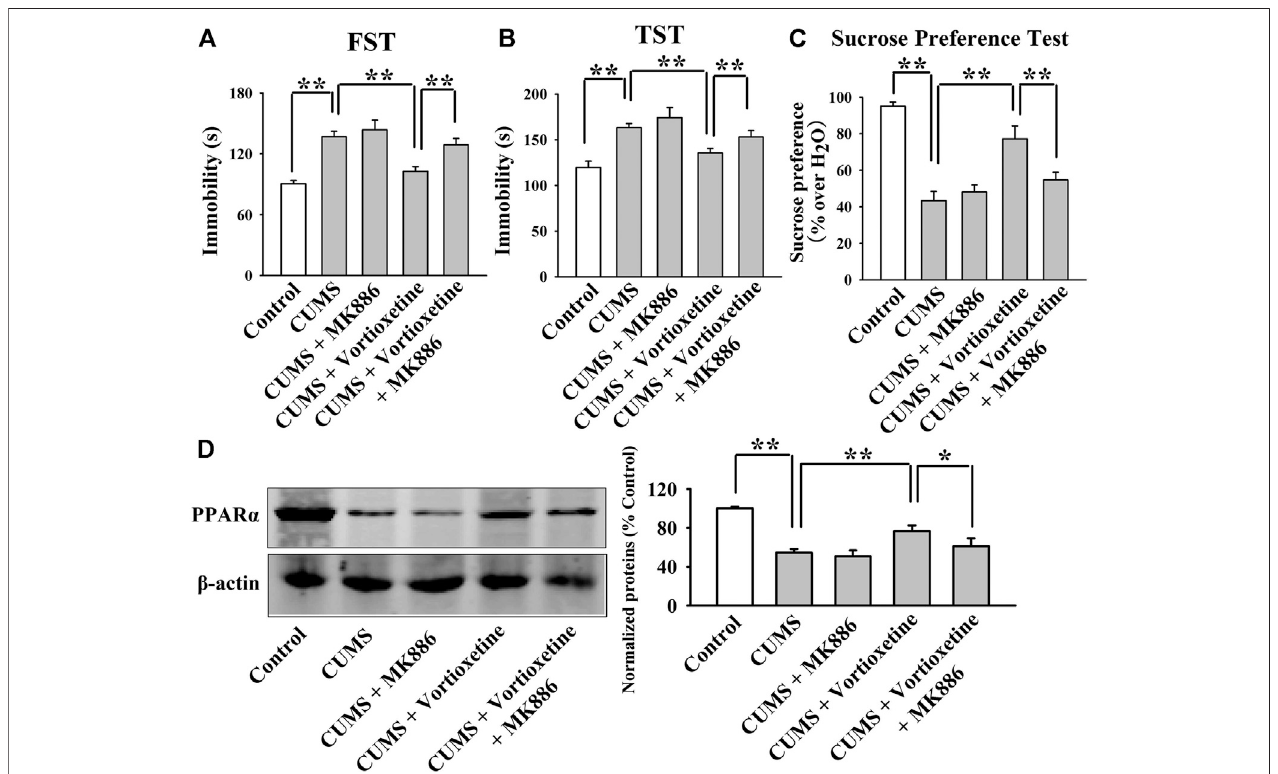
FIGURE 5 | The antidepressant effects of vortioxetine in the CUMS model were signi fi cantly prevented by MK886 co-treatment. (A – C) The reversal effects of vortioxetine on the CUMS-induced depressive-like behaviors in mice were signi fi cantly prevented by MK886 co-treatment, as indicated by the FST, TST and sucrose preference test. (D) Representative images and quantitative analyses show that the use of MK886 notably blocked the enhancing effects of vortioxetine on the hippocampalPPAR α expressionintheCUMS-exposedmice.For (A – C) , n (cid:2) 10pergroup;For (D) , n (cid:2) 5pergroup.Thedataareexpressedasthemeans ± S.E.M.; * p < 0.05, ** p < 0.01. The comparisons were made by two-way ANOVA followed by Bonferroni ’ s